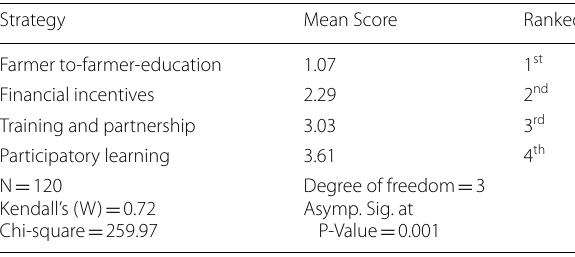
Source: Field survey (2018)